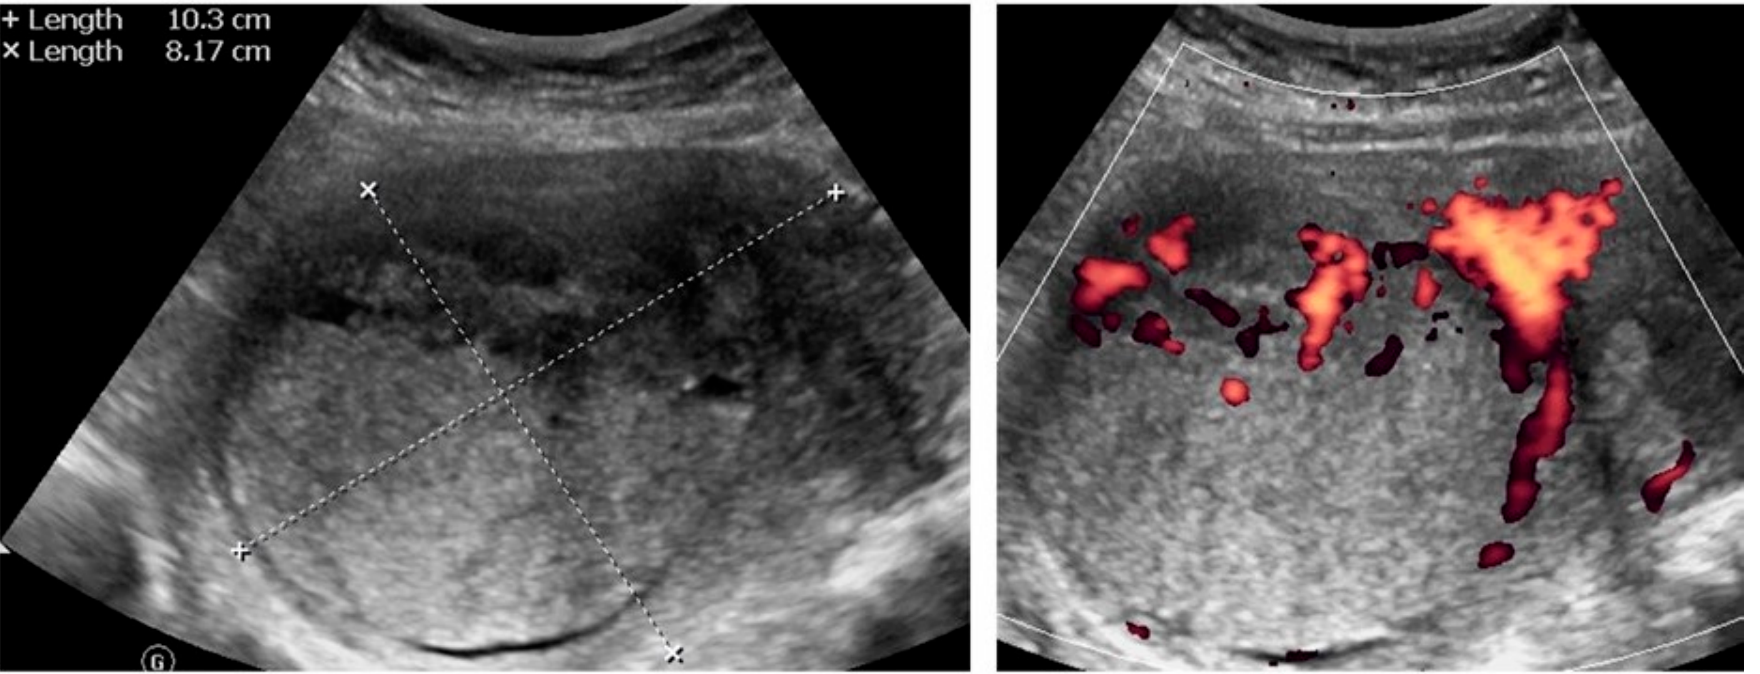
Figure A8. Transabdominal ultrasonogram (convex probe) of the uterine lesion (atypical) in the myometrium, B mode and Doppler. Histology: STUMP.